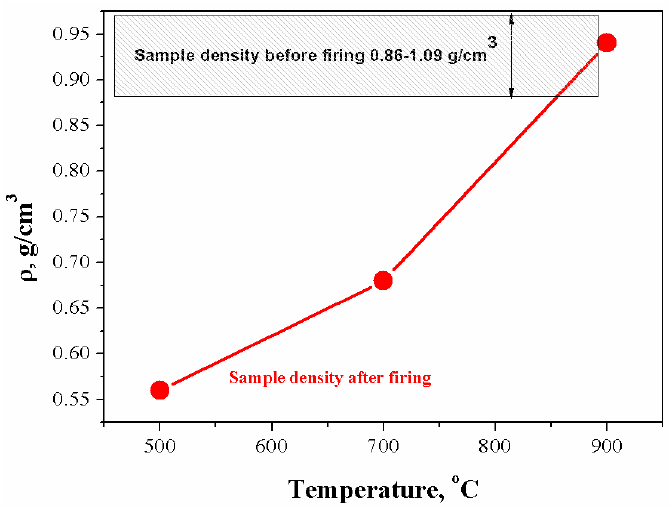
Figure 5. Geometric density of ceramic samples, obtained by annealing of cement-salt stone in the temperature range of 500–900 °C.